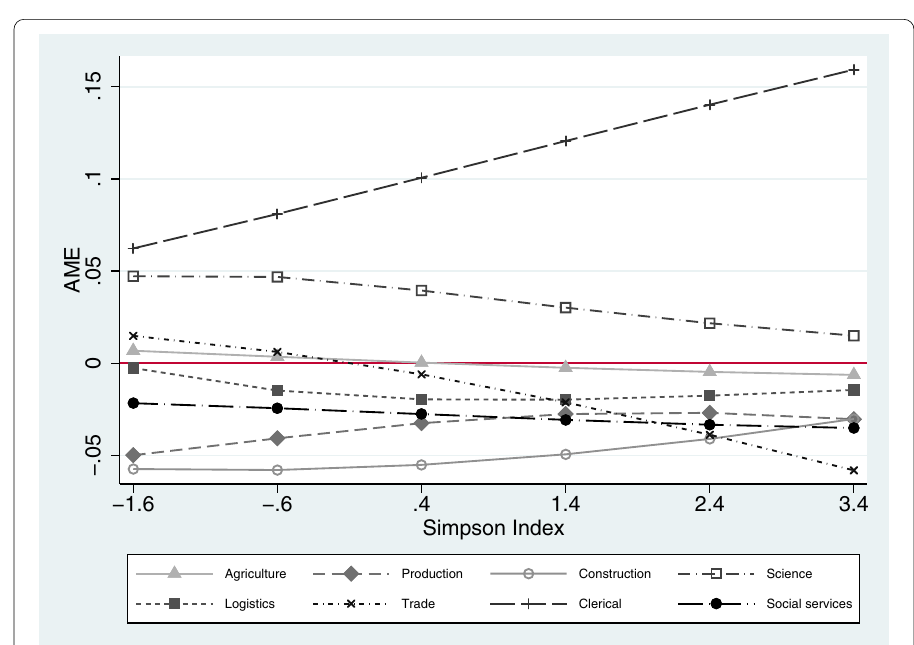
Fig. 10 Interaction of diversity index with ISS in reference to LSS degree. Data source: NEPS, SC4, estimation see Table